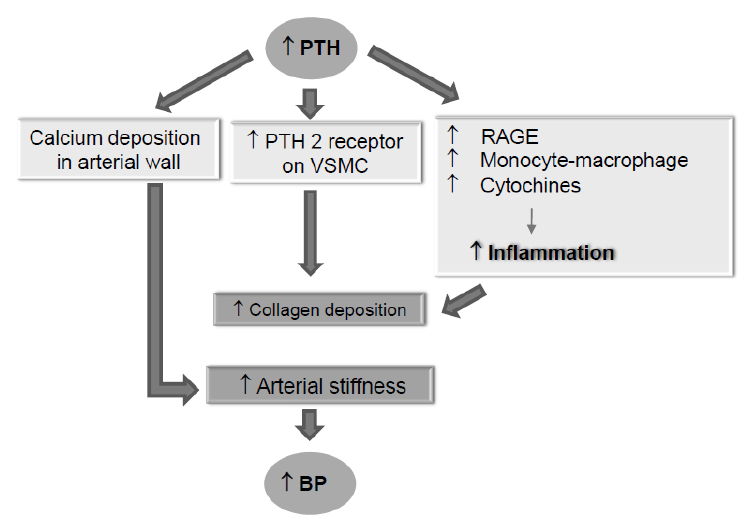
Figure 2. Mechanisms involved in hyperparathyroidism-related blood pressure increase. VSMC: vascular smooth muscle cell.